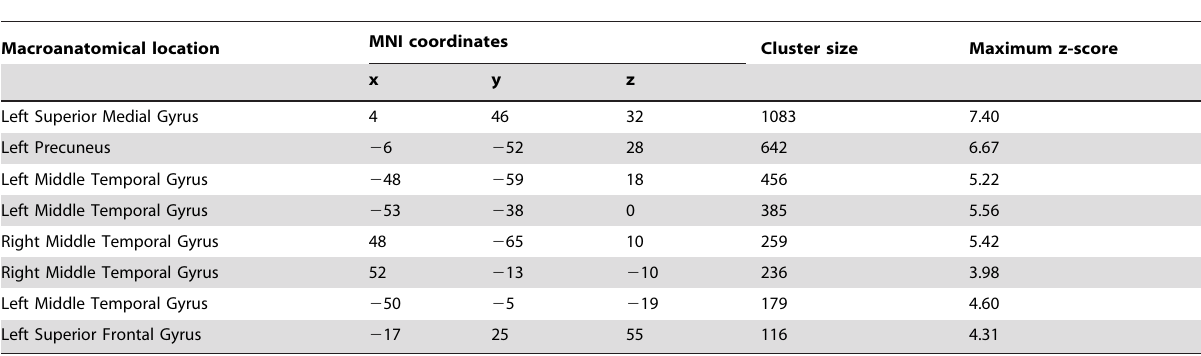
Table 1. Activation peaks of ALE meta-analysis of the neural correlates of social cognition tasks (SOC).